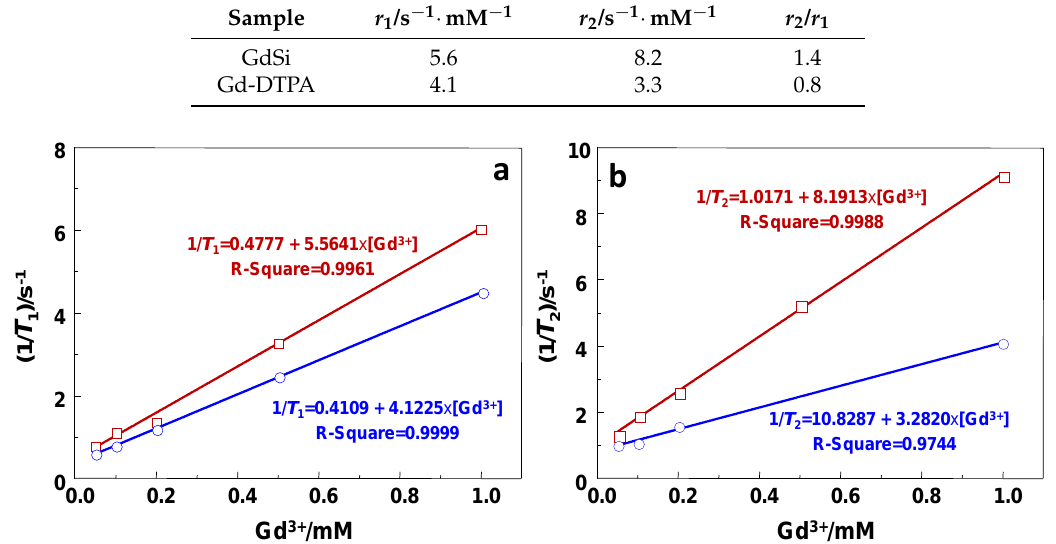
Figure 5. T 1 ( a ) and T 2 ( b ) relaxation rate measurements vs concentration of GdSi aqueous solutions (0.1% xanthan gum) at a magnetic field of 3 T. Legend: ( □ ) GdSi; ( ◦ ) Gd-DTPA.